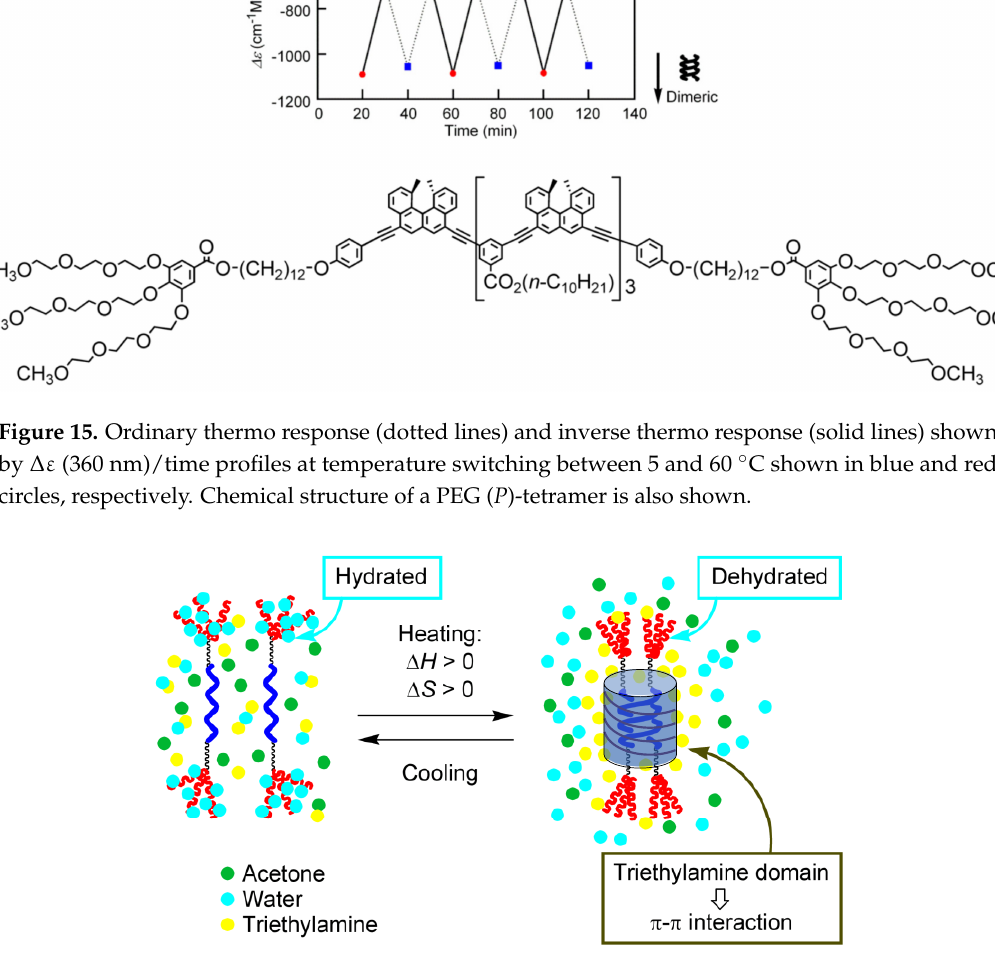
Figure 16. Possible mechanism of inverse thermo response.